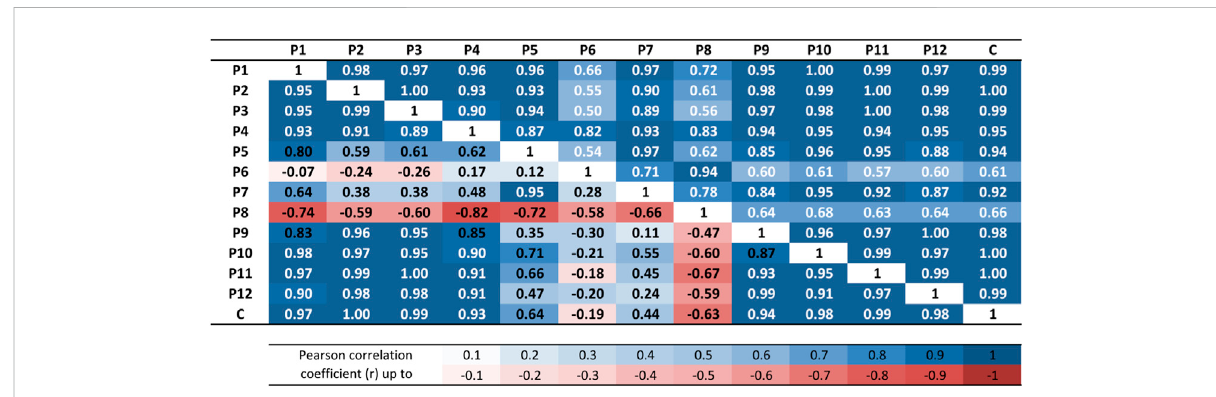
FIGURE 5 Below the diagonal: correlations between the weighting vectors resulting from comparing the ecological criteria among the 12 participants (P1 to P12) and the group consensus (C); values correspond to Pearson ’ s correlation coef fi cient (white values indicate signi fi cant correlations, p value < 0.05).Abovethediagonal:correlationsbetweentheEcologicalValue(EV)mapsofthe12participants(P1toP12)andthegroupconsensus(C); values correspond to Pearson ’ s correlation coef fi cient (white values indicate signi fi cant correlations, p value <